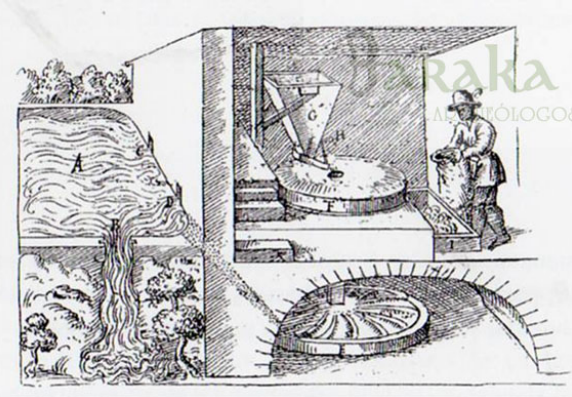
Figure 5: Horizontal mills or